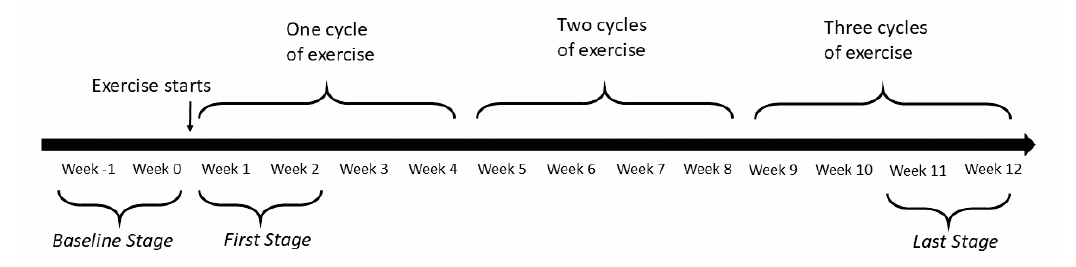
Figure 1. Timeline of study.